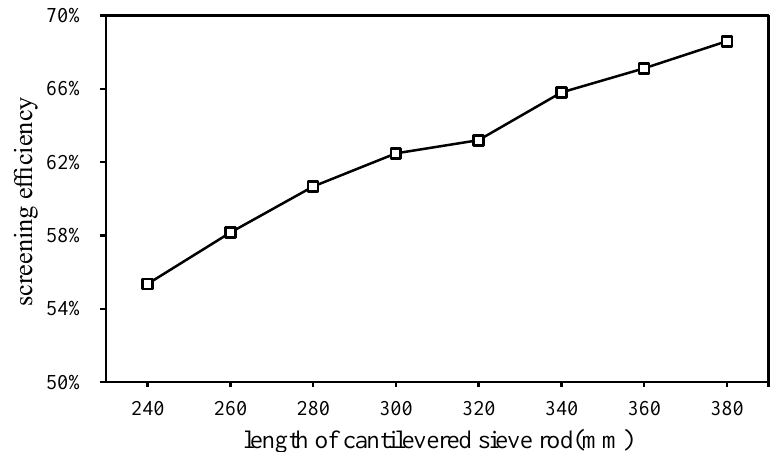
Figure 7. Screening efficiency of a cantilevered vibrating sieve (CVS) for different length of cantilevered sieve rod.